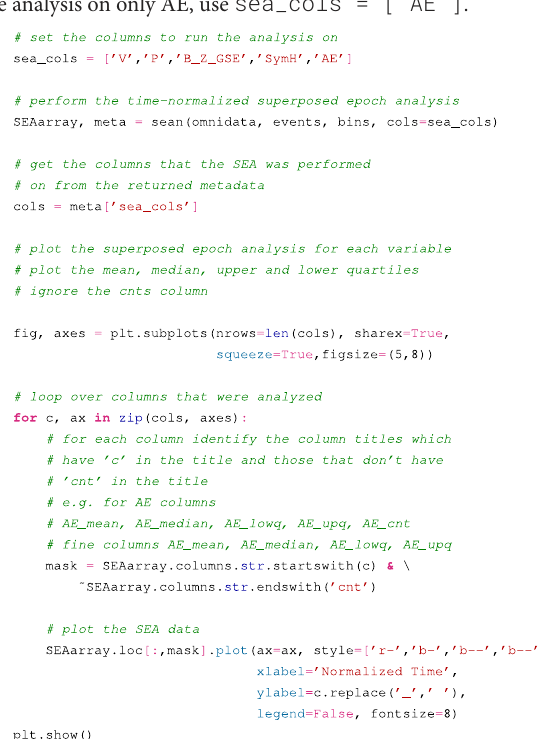
to bottom, V, P, B